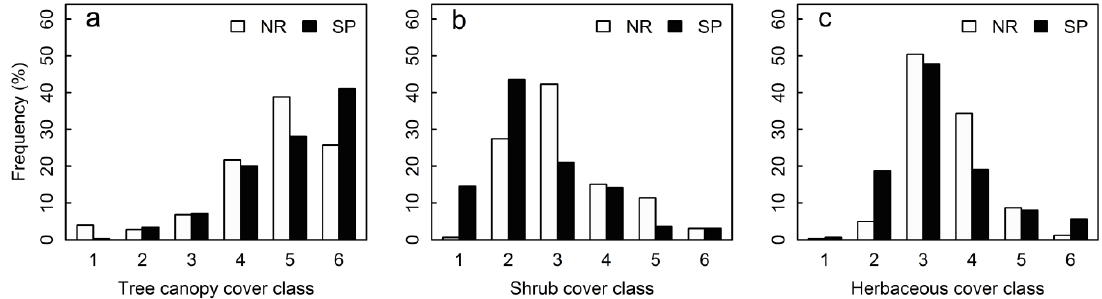
Figure 1. Frequency distribution for covers of tree canopy, shrubs, and herbs at four m 2 shrub quadrats ( a , b ) and at one m 2 herb quadrat ( c ) within the naturally regenerated forests (NR, n = 324) and the reforested spruce forests (SP, n = 324) originating from clear-cuts in the eastern Tibetan Plateau. Cover classification was followed by a modified Braun-Blanquest cover abundance scale, as described by Hurst and Allen (2007) [26], including Cover classes 1 (<1%), 2 (1%–5%), 3 (6%–25%), 4 (26%–50%), 5 (51%–75%), and 6 (76%–100%).